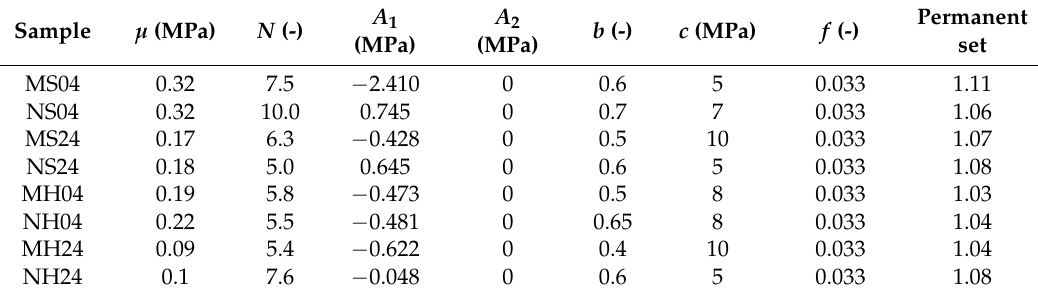
Table 3. Material constants used to fit the cyclic experimental data.